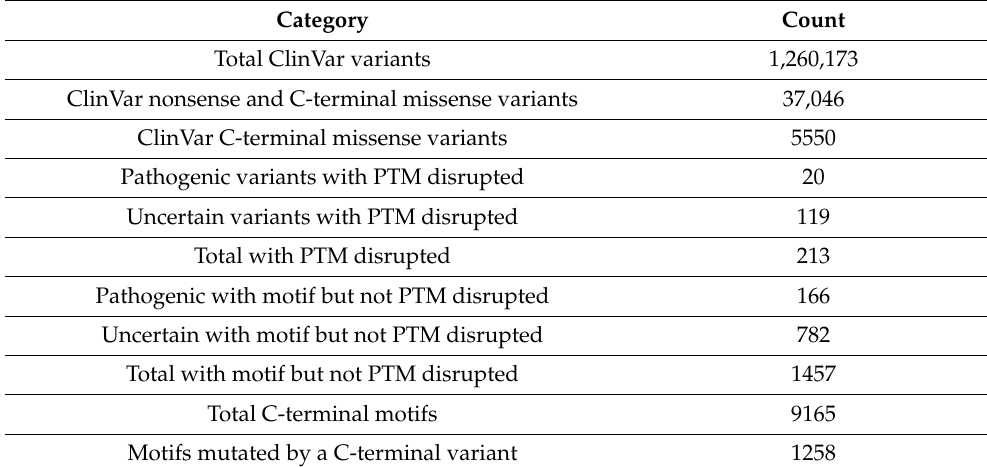
Table 2. ClinVar mutation statistics.